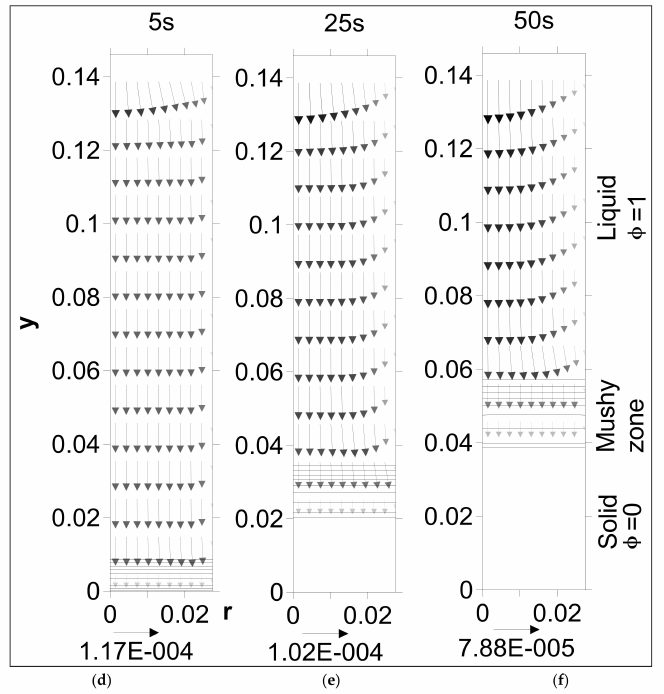
Figure 10. Development of fluid flow velocities (m.s − 1 ) in ( a – c ) for solidification simulation S2 with effect of undercooling for t = 5 s, 25 s and 50 s, respectively, and ( d – f ) for solidification simulation S1 without effect of undercooling for t = 5 s, 25 s and 50 s, respectively. The magnitudes of maximum velocities are presented at the bottom of ( a – f ).